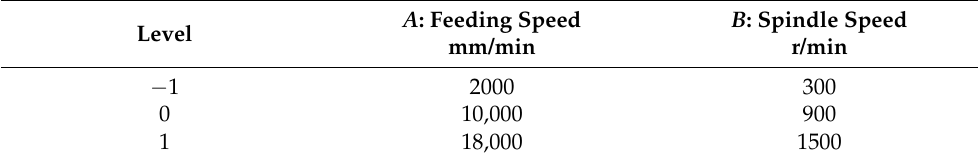
Table 2. Factor-level design table of response surface method.